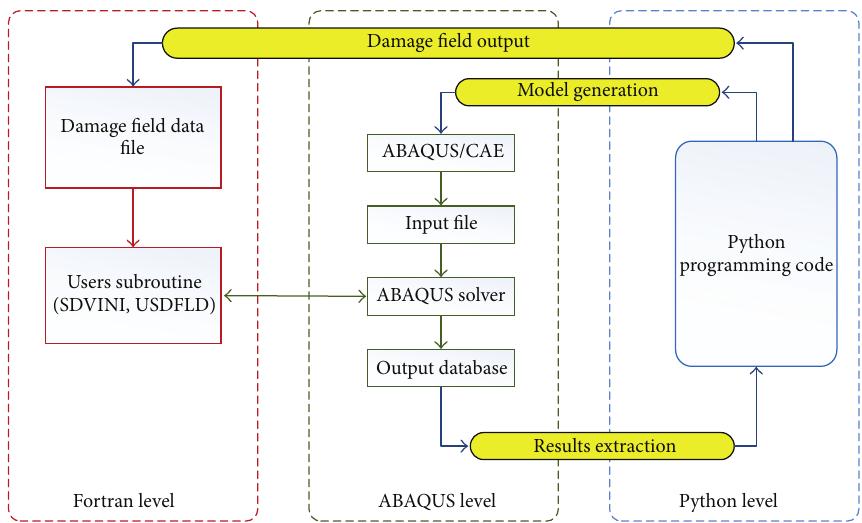
Figure 1: Numerical scheme for damage mechanics-finite element